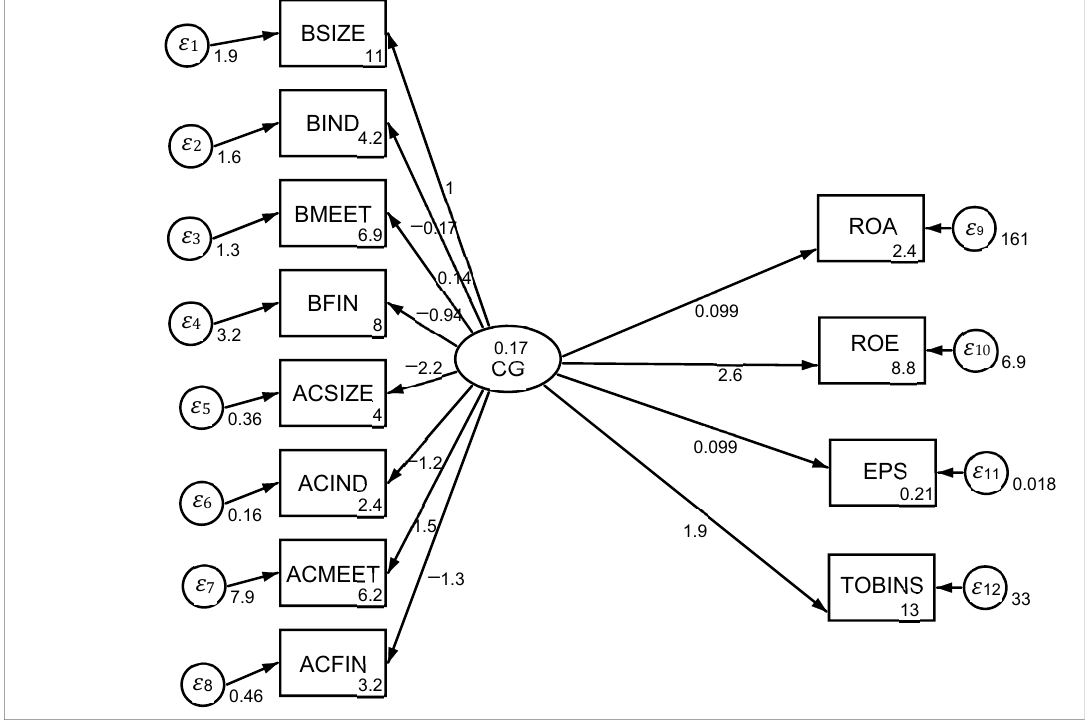
Figure 1. Result of corporate governance and bank performance.